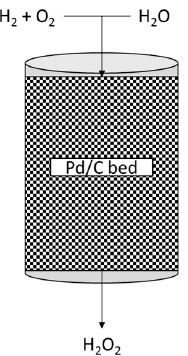
Figure 3. Trickle bed reactor used by Gallina et al. [68] to produce H 2 O 2 directly from H 2 and O 2 in water in the presence of a commercial Pd/C catalyst (Scheme modified from Gallina et al. [68], 2017, copyright 2017. Reprinted here with the kind permission of the American Chemical Society).